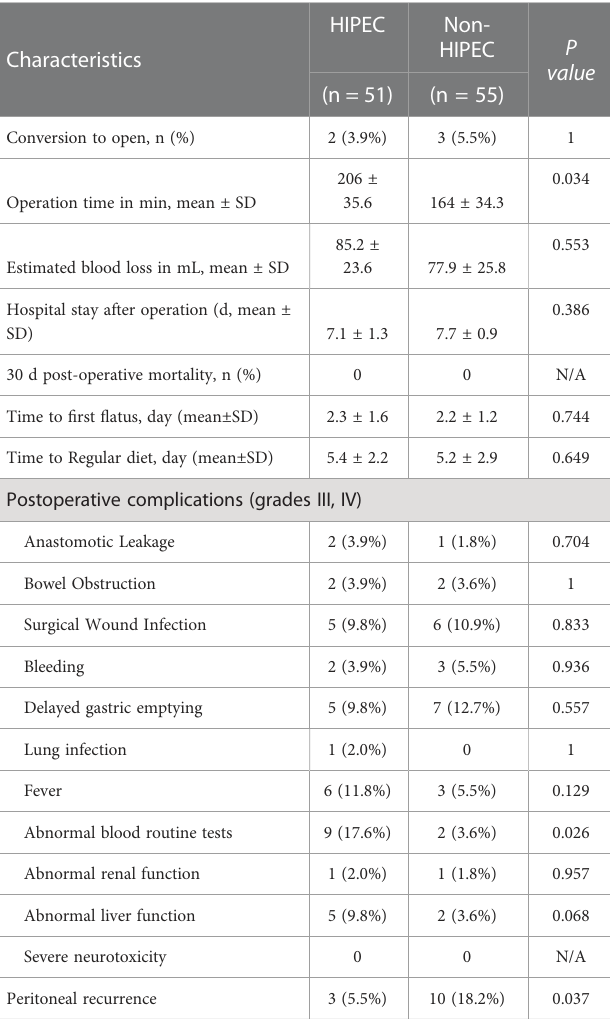
Characteristics